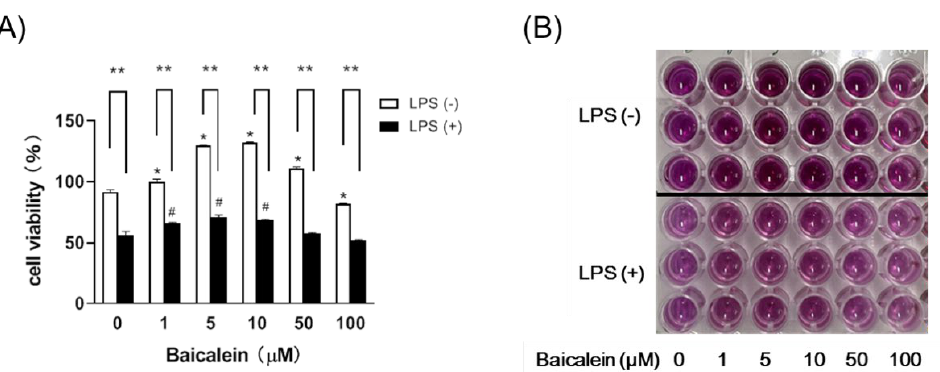
Figure 2. Baicalein effectively relieves LPS-induced damage in liver macrophages, as assessed by the MTT assay. ( A ) The viability of liver macrophages increased upon treatment with 1–10 µM of baicalein. Data are presented as means ± SEM. * p < 0.05 and # p < 0.05 indicate significant differences compared with the respective control group (0 µM Baicalein). Administration of LPS (+LPS) in the cell medium markedly reduced viability, but treatment with baicalein significantly restored the viability of macrophages. Data are presented as means ± SEM. ** p < 0.01 indicates significant differences compared with the respective LPS ( − ) group. ( B ) The results of the MTT assay.